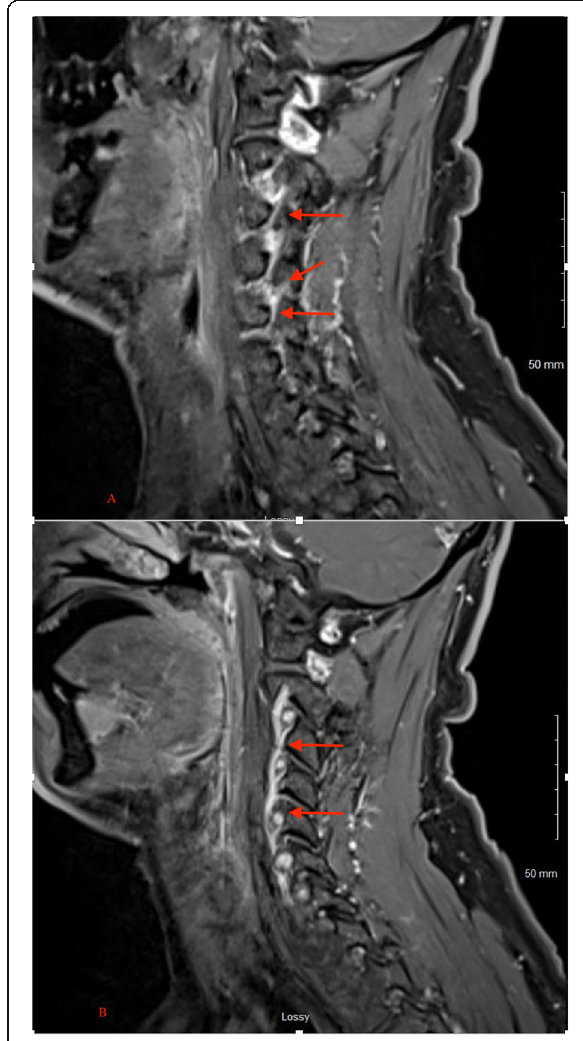
Fig. 2 a , b The sagittal section of MRI cervical spine – T2. Contrast image shows contrast enhancement of the spinal nerve along with dorsal root